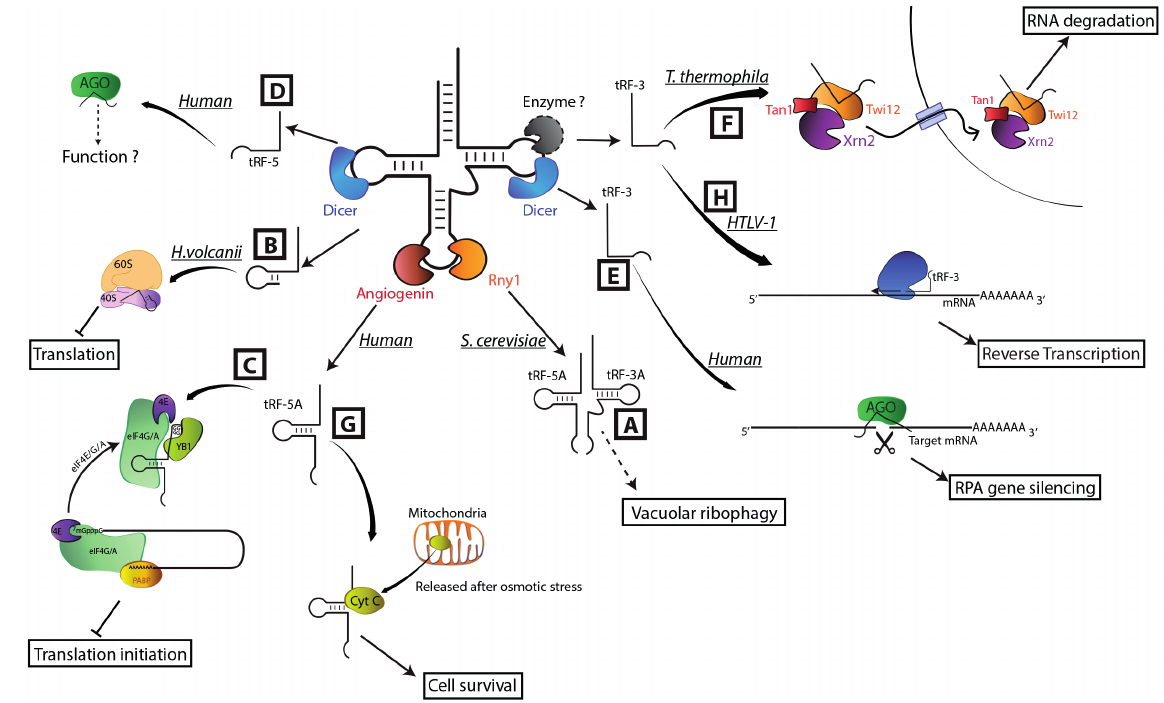
Figure 2. Summary of our knowledge on the major identified molecular functions assigned to tRFs. References for the functional implications of tRFs are the following: ( A ) [89]; ( B ) [56]; ( C ) [97]; ( D ) [73]; ( E ) [74]; ( F ) [98]; ( G ) [99]; ( H ) [100]. Straight arrows indicate the generated tRFs and bent arrows their functions. Dashed arrow indicates potential